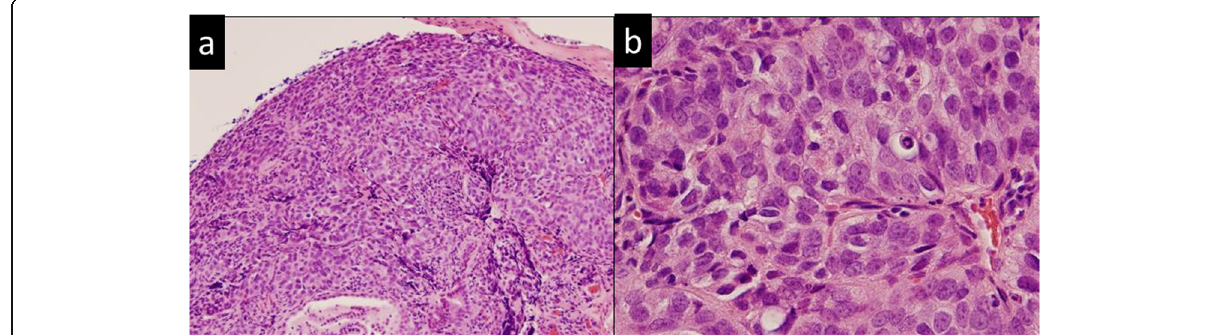
Fig. 4 Histopathological findings of the biopsy specimen of the tumor. a Low-power field. b High-power